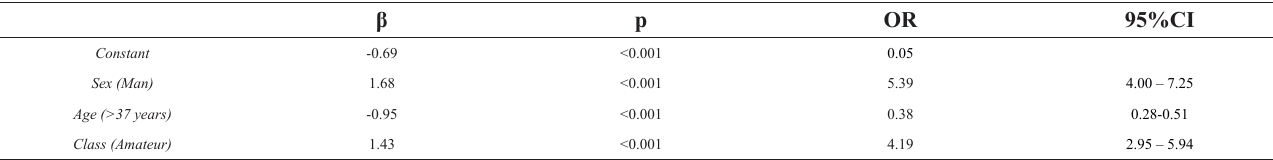
Table 4 - Regression logistic analysis of associated runner’s performance